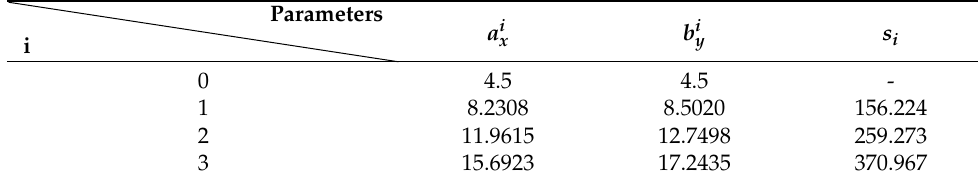
Table 2. Parameters of discrete regions ( n = 3).